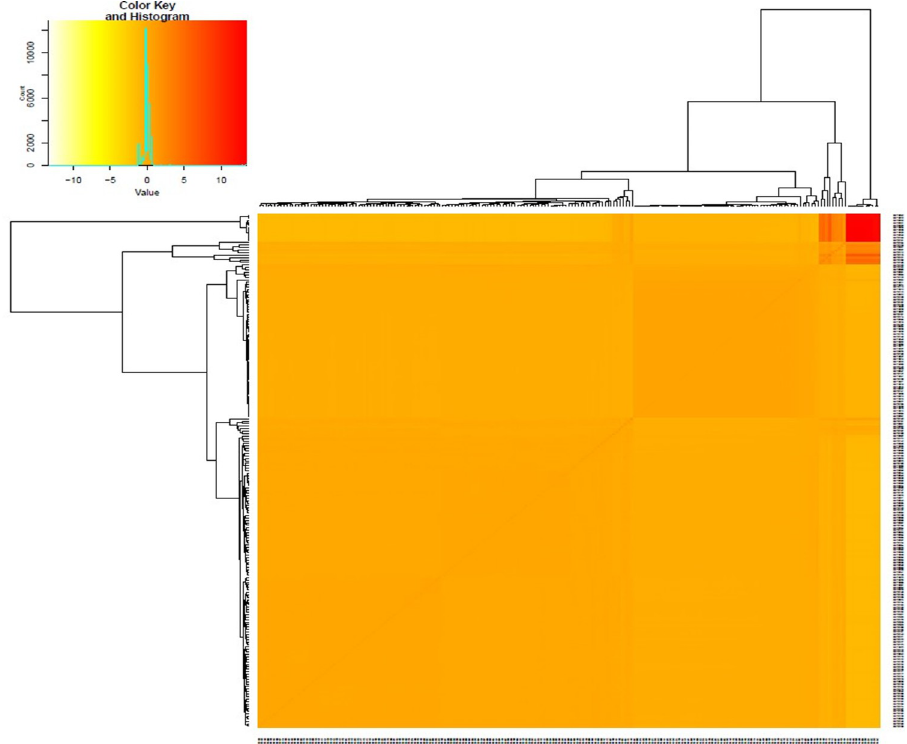
Fig 3. Heat map plot of kinship matrix using average linkage clustering based on SNP markers. https://doi.org/10.1371/journal.pone.0277537.g003 genotypes from Ghana (82 genotypes; 41.8%) followed by Nigeria (76 genotypes; 38.8%) (Fig 6B). Cluster two only consisted of 11 genotypes (6.0%). These were in accordance with results from STRUCTURE analysis. The DAPC biplot, together with the plot of densities of individuals on the first discriminant function, showed a clear separation of the yam genotypes into three clusters with minimal admixed individuals at K = 3. Furthermore, the three discrim- inant functions, which explained cluster one (59 genotypes; 28.5%), cluster two (137 geno- types; 66.2%), and cluster three (11 genotypes; 5.3%) obtained (Fig 6C). Cluster two which contributed the highest number of genotypes consisted of primarily Dioscorea rotundata Table 1. Analysis of molecular variance within and among the 207 genotypes assessed with 4,957 SNP markers. SOV a df b SS c MS d Est. Var. e Among Pops